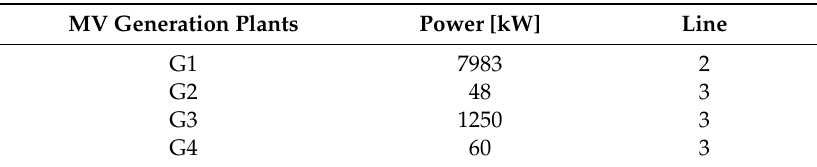
Table 2. MV PV Table 2. MV PV Generators.